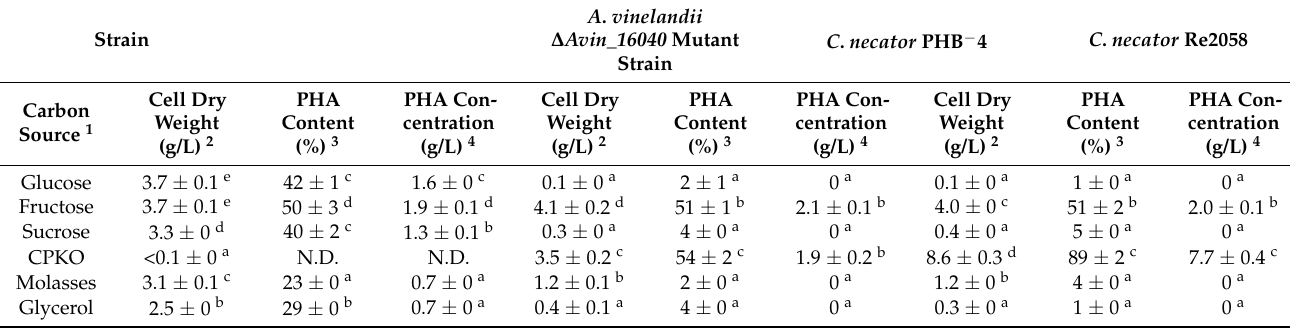
Table 5. Biosynthesis of PHAs by C . necator PHB − 4 and C . necator Re2058 harbouring phaC of A . vinelandii mutant strain using different carbon